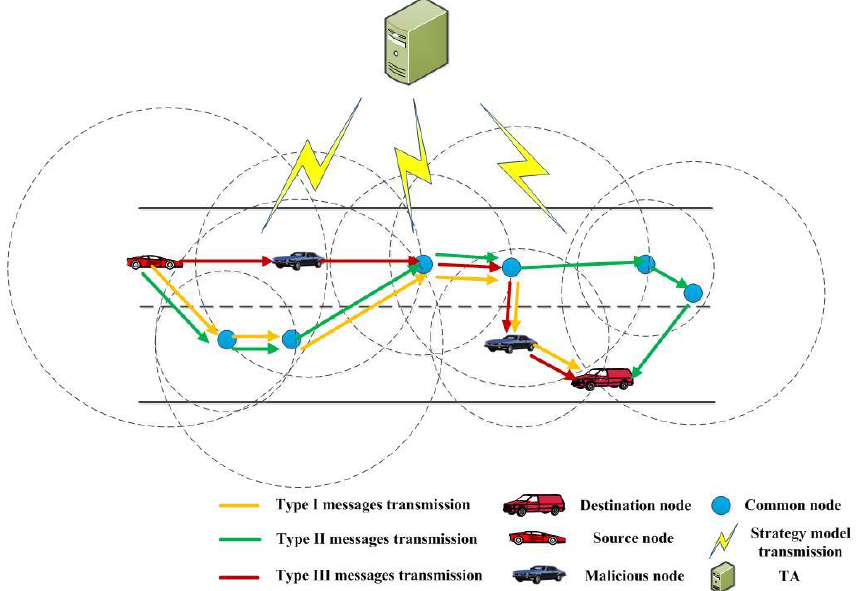
Figure 1. Schematic diagram of routing decision scenario.